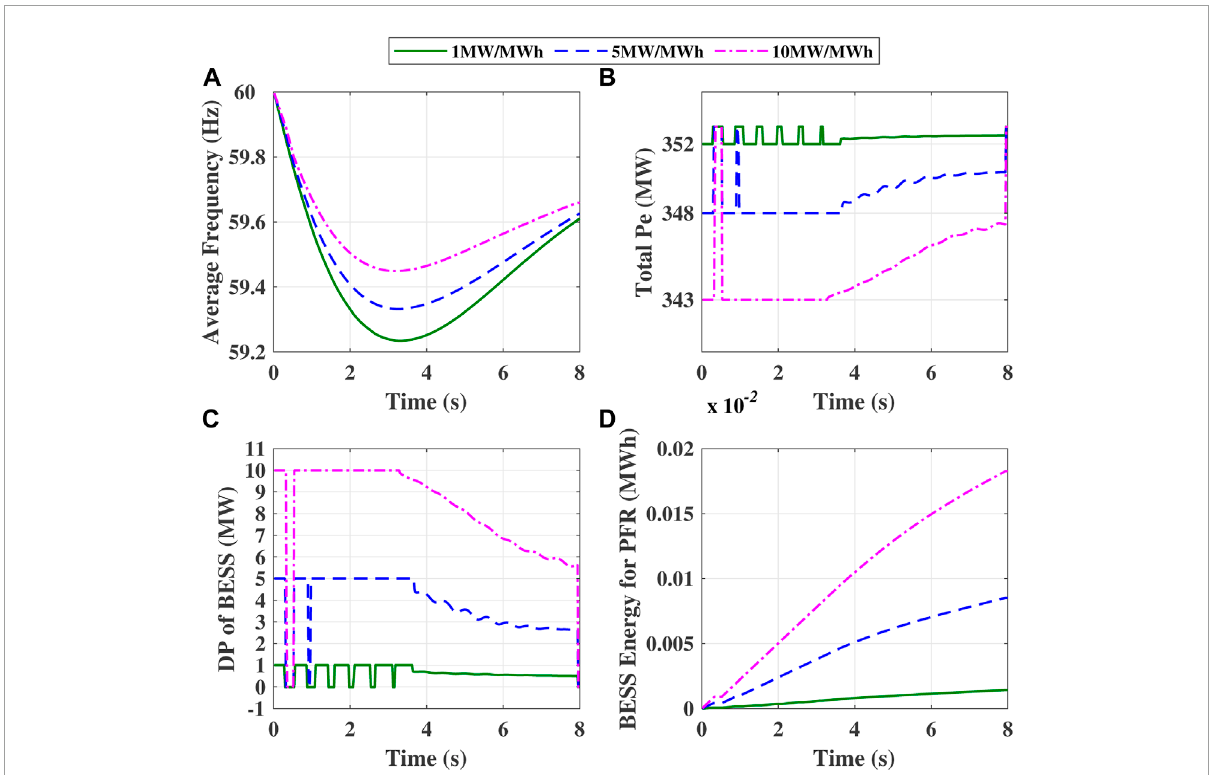
FIGURE 7 Curves (average frequency curve, total Pe curve, DP of BESS curve and BESS energy for PFR curve) for different BESSs providing power injection for the load increase of 0.38 pu.